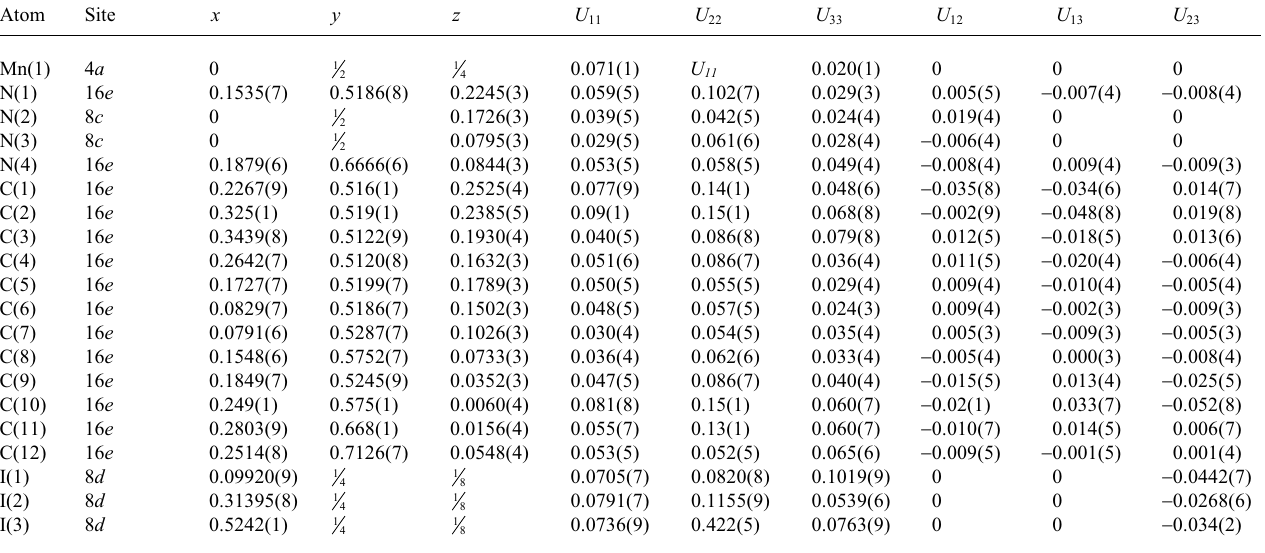
Table 3. Atomic coordinates and displacement parameters (in Å 2 ).